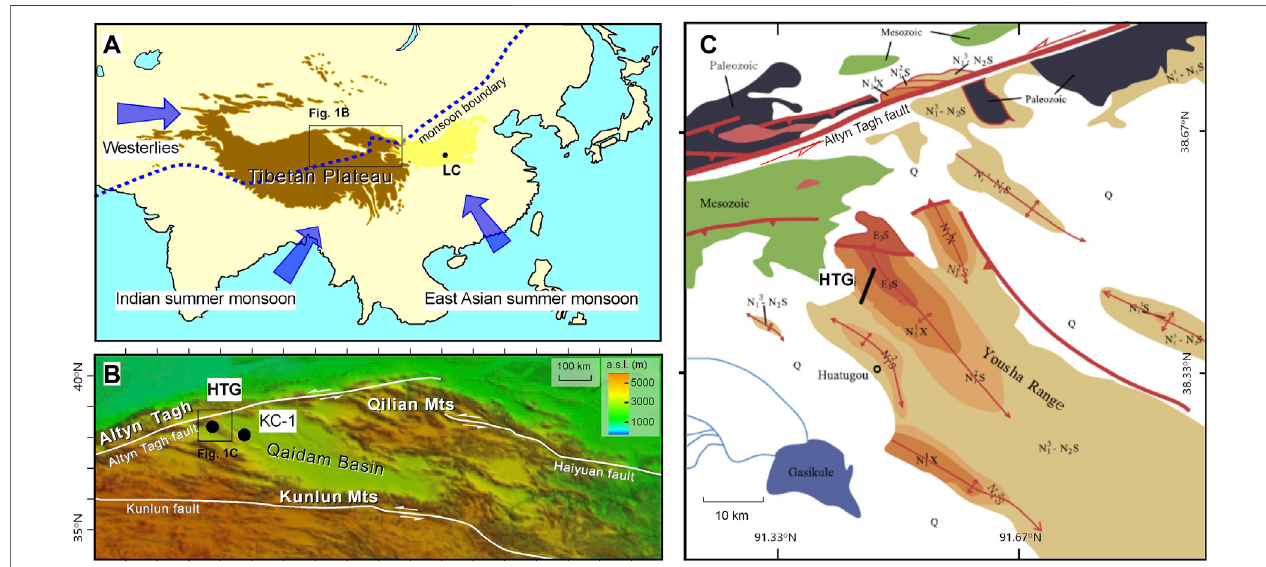
FIGURE1| PhysiographicmapofinnertoeasternAsia,showingthelocationsforthewild fi restudy. (A) .GeographicmapoftheTibetanPlateau,showingthestudy area and a simpli fi ed representation of atmospheric circulation. LC section in the Loess Plateau (yellow area) isfor reference (Han et al., 2020). (B) . Morphotectonic map of Qaidam Basin and the location, of the HTG section that was sampled in this study, and of the KC-1 core (Miao et al., 2019). (C) . Geological map of the Youshashan